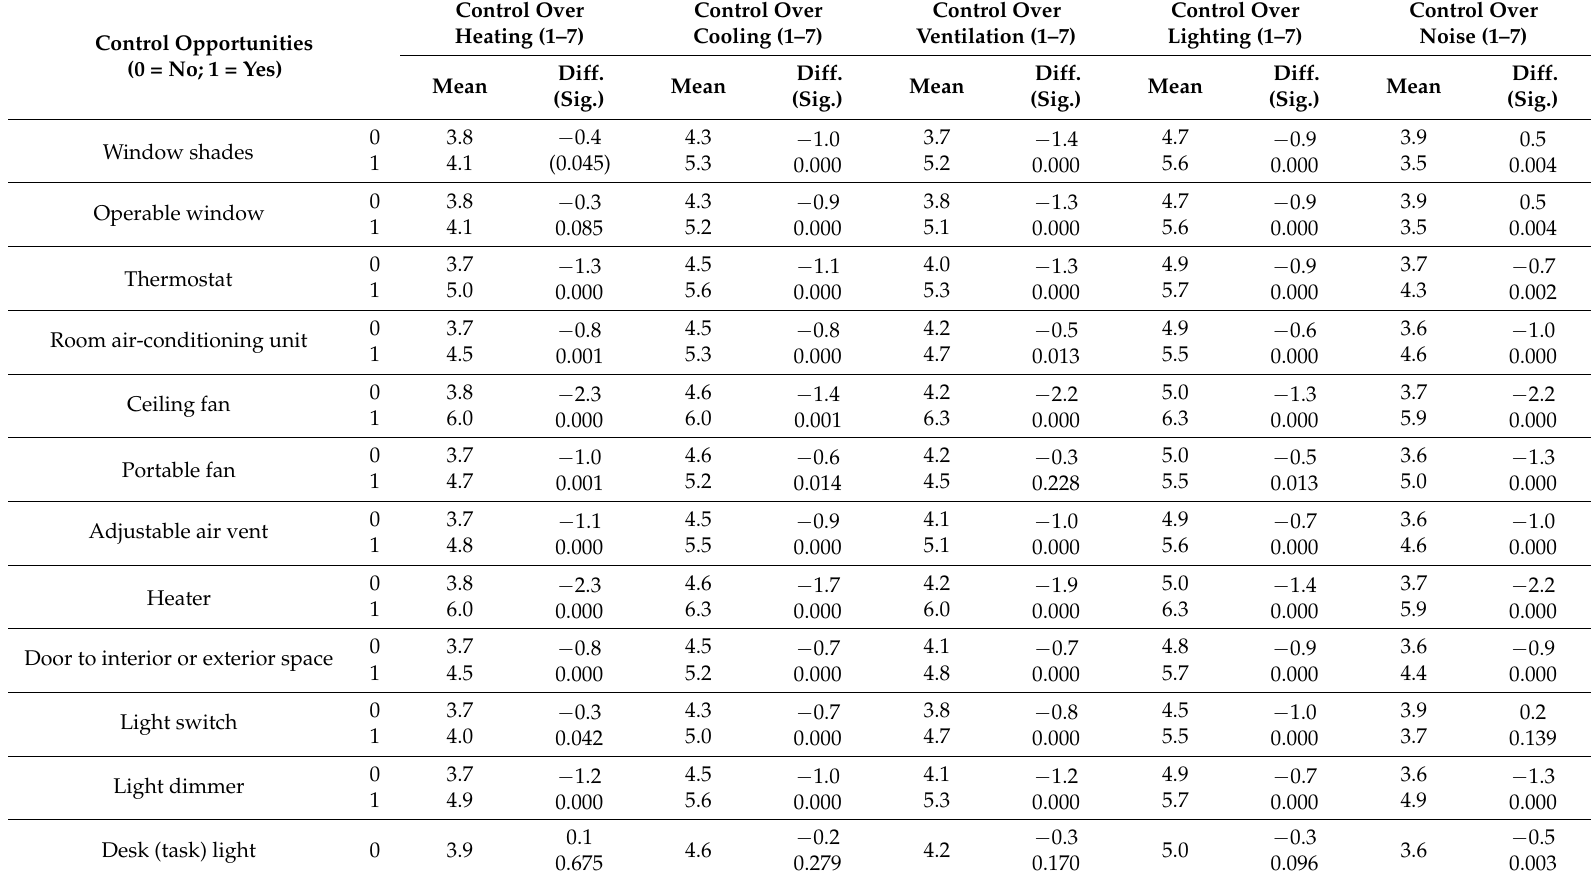
Table 6. Control opportunities and degree of